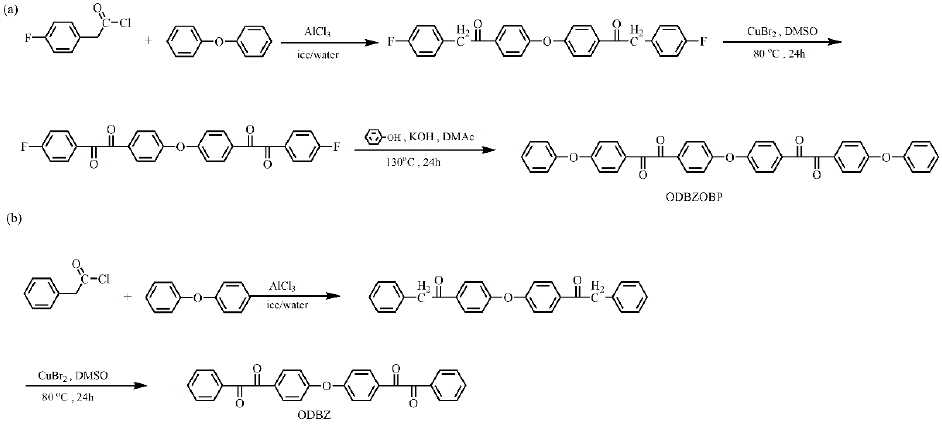
Figure 1. Synthesis of monomers ODBZOBP ( a ) and ODBZ ( b ).